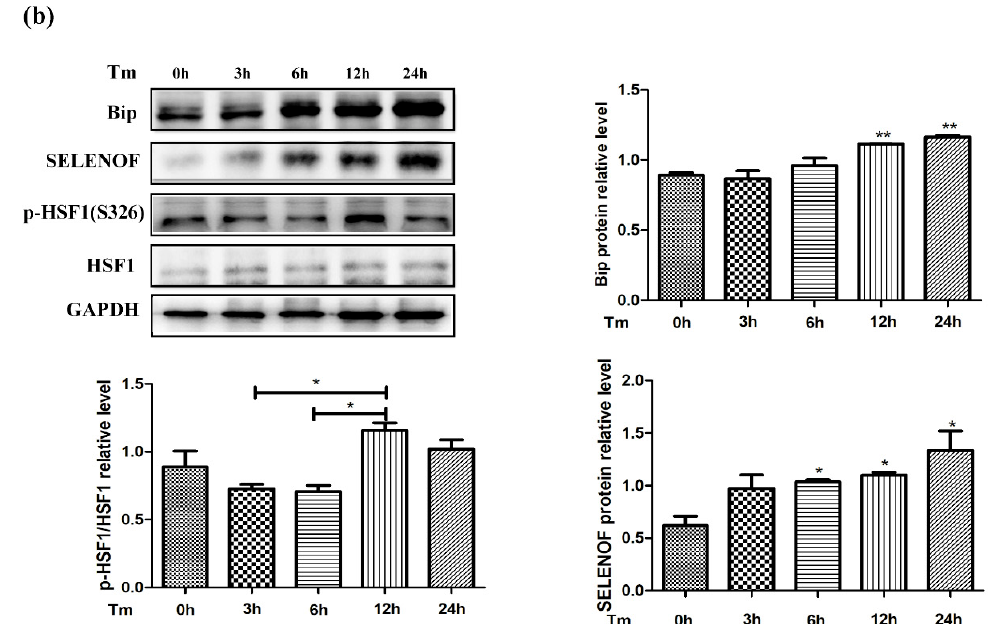
Figure 6. The e ff ect of selenate and Tm treatment on the endogenous HSF1 activation and SELENOF protein levels. ( a ) Protein levels of SELENOF, p-HSF1 (S326), and HSF1 at several time intervals in HEK293T cells treated with selenate. ( b ) Protein levels of Binding immunoglobulin protein (BIP), SELENOF, p-HSF1 (S326), and HSF1 at several time intervals in HEK293T cells treated with Tm. BIP bands were used as protein markers for adaptive endoplasmic reticulum (ER) stress. The data are representative of three independent experiments. * p < 0.05, ** p < 0.01 and *** p < 0.001.